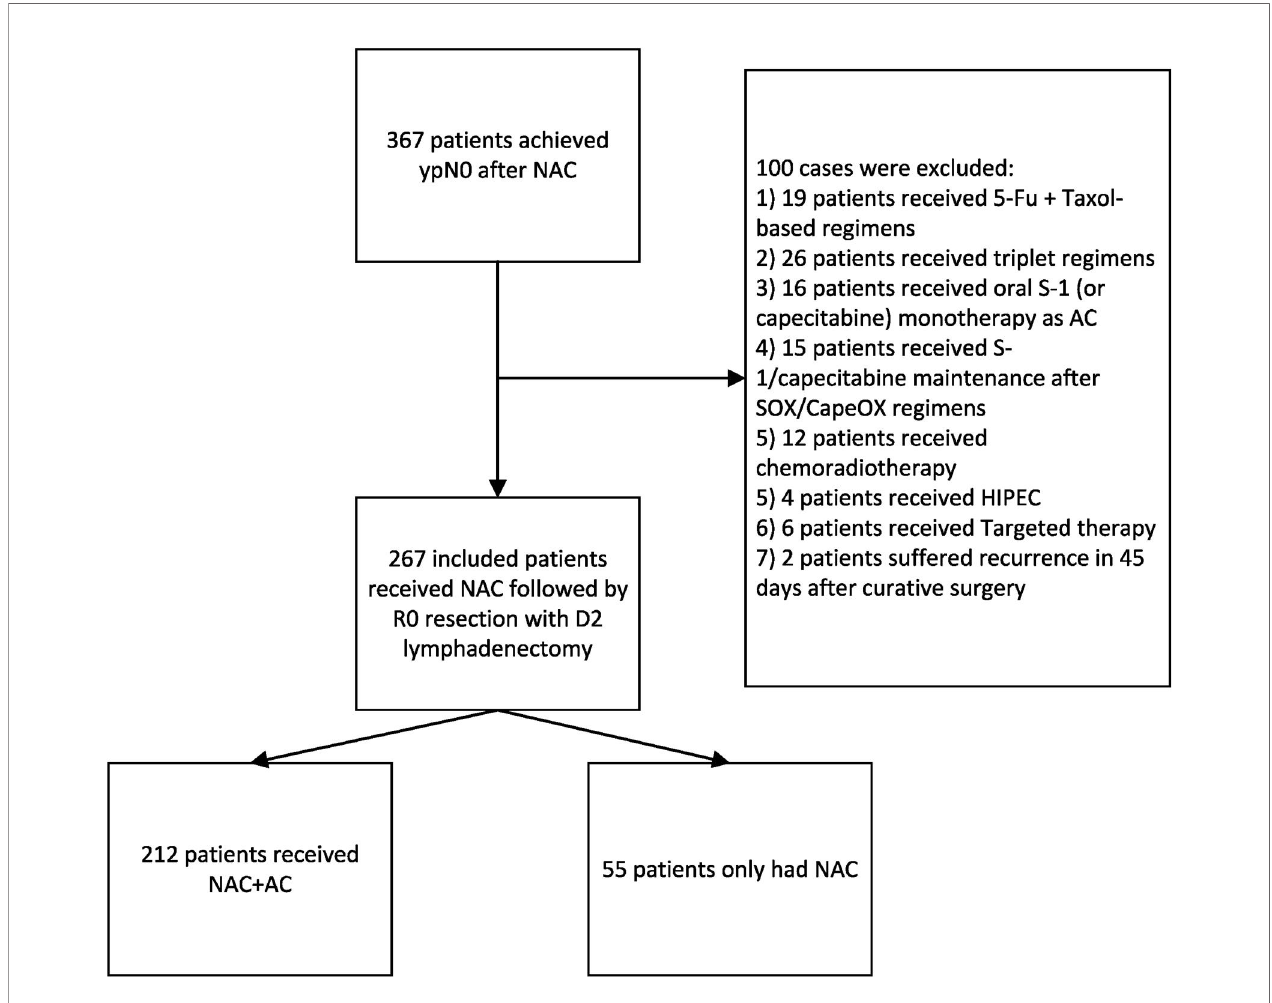
FIGURE 1 | Flowchart showing patient enrolment.